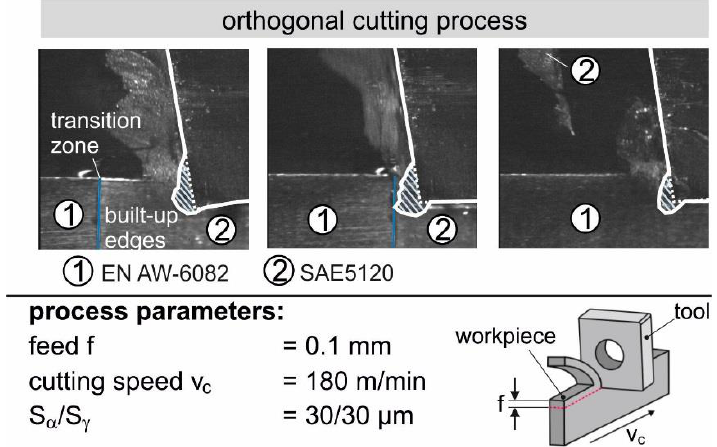
Figure 9. Built-up edges during orthogonal cutting of steel-aluminium alloy .